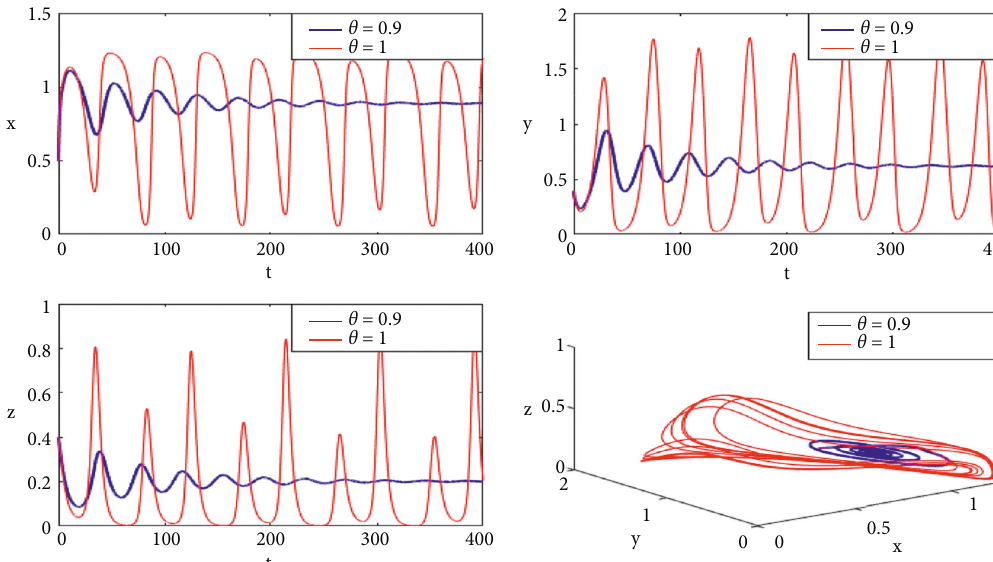
Figure 9: Case 5: the trajectories and phase diagrams of system (92) at τ